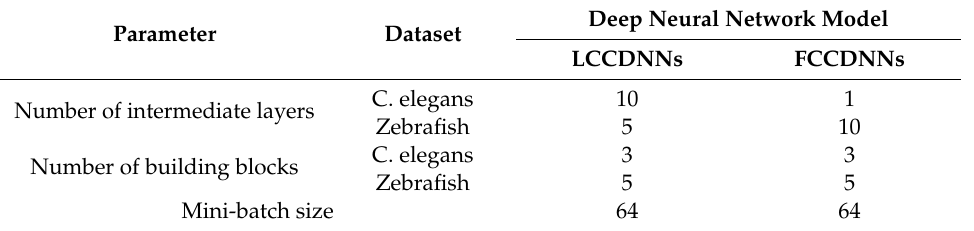
Table 2. The base building block parameter settings of the LCCDNNs and FCCDNNs.